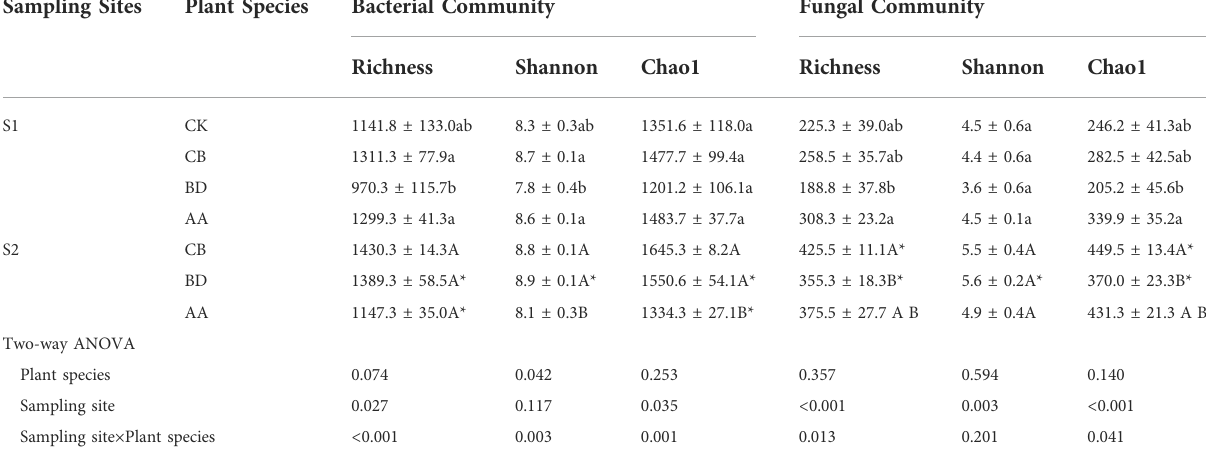
TABLE 2 Soil bacterial and fungal diversities for bare soils and rhizosphere soils of three metal-tolerant plants at S1 and S2.